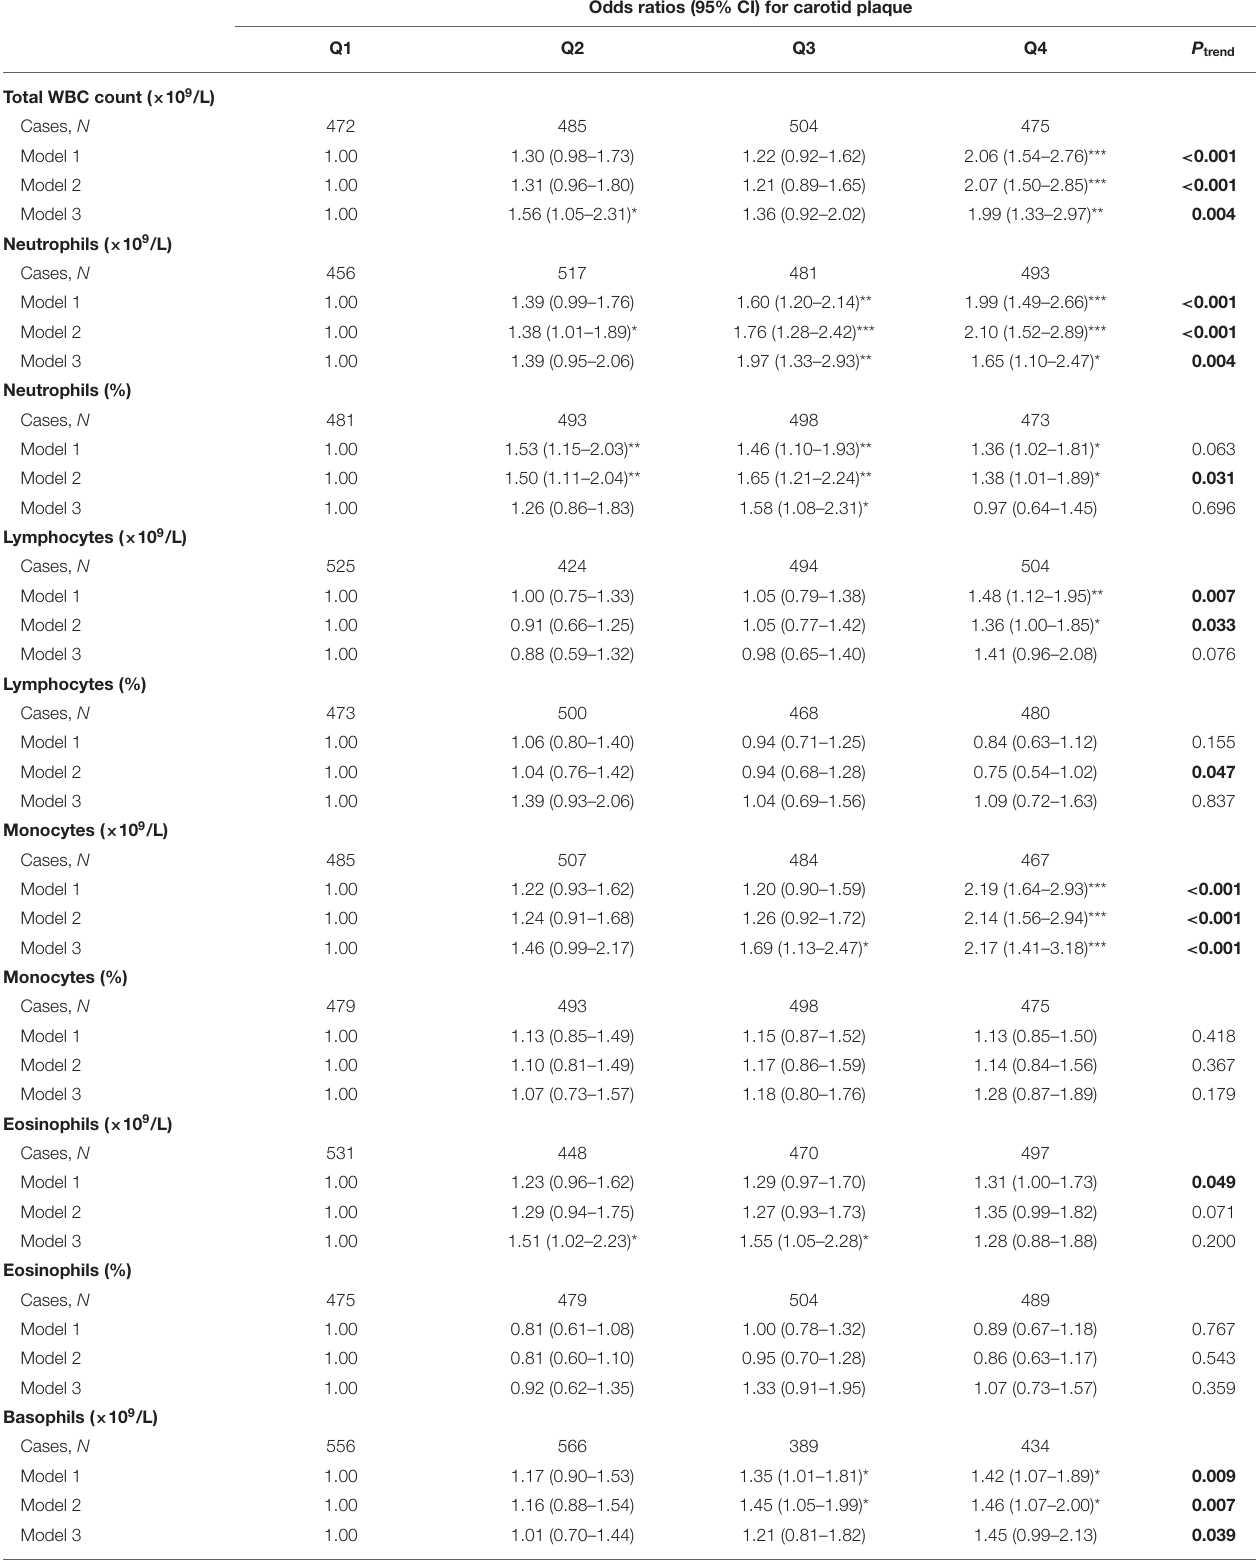
TABLE 2 | Odds ratios and 95% CI for carotid artery plaque by quartiles of the total white blood cell (WBC) and differential WBC counts for men. Odds ratios (95% CI) for carotid plaque Q1 Q2 Q3